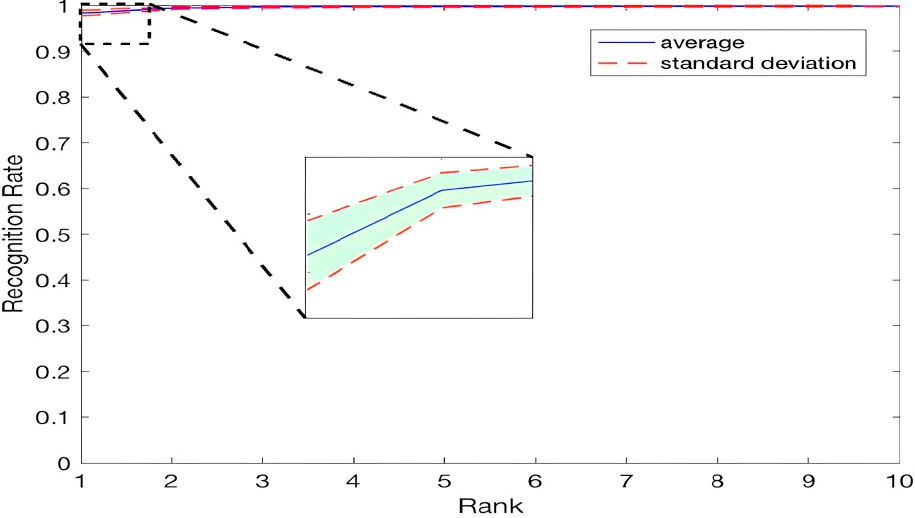
Figure 10. CMC Curve for the Top 10 Rank. Table 10. Authentication System Results (EER).